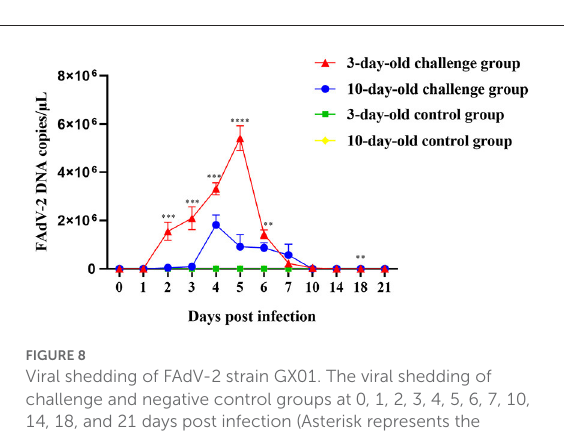
FIGURE8 Viral shedding of FAdV-2 strain GX01. The viral shedding of challenge and negative control groups at 0, 1, 2, 3, 4, 5, 6, 7, 10, 14, 18, and 21 days post infection (Asterisk represents the significant difference in virus shedding between the 3-day-old challenge group and the 10-day-old challenge group on the same